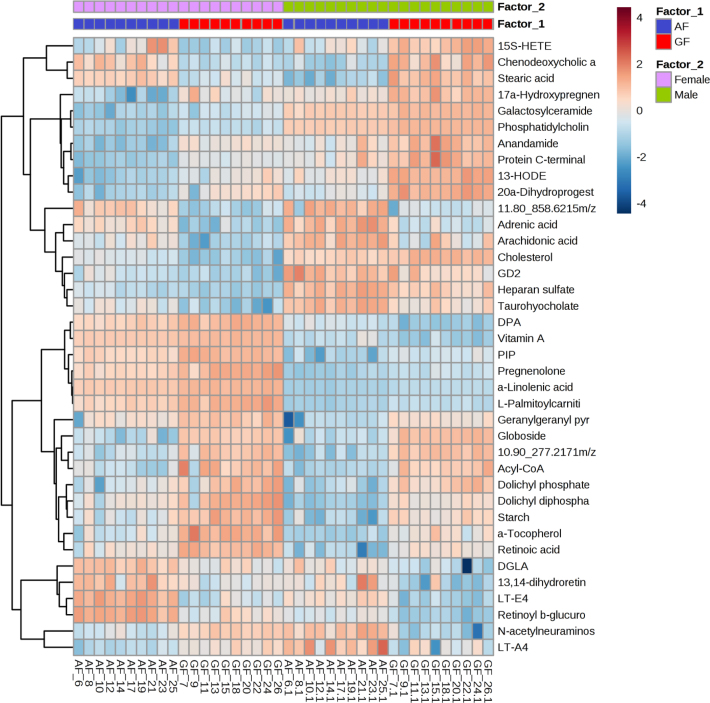
The differential and overlapped metabolites between the four test groups. Heat map visualization of metabolomic data shows the relative intensities of significant features; those are not only annotated by existing metabolites database and also overlapped among the four test groups (FAF, FGF, MAF, and MGF). Each row was labeled with the tentative metabolite names. The colors refer to the relative levels of these compounds from high (red) to low (blue).